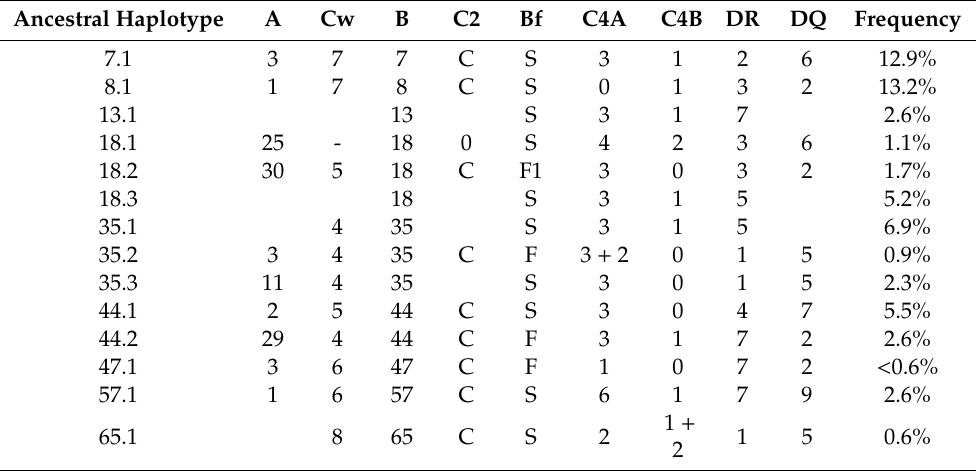
Table 3. Haplotype definitions and frequencies in an Australian